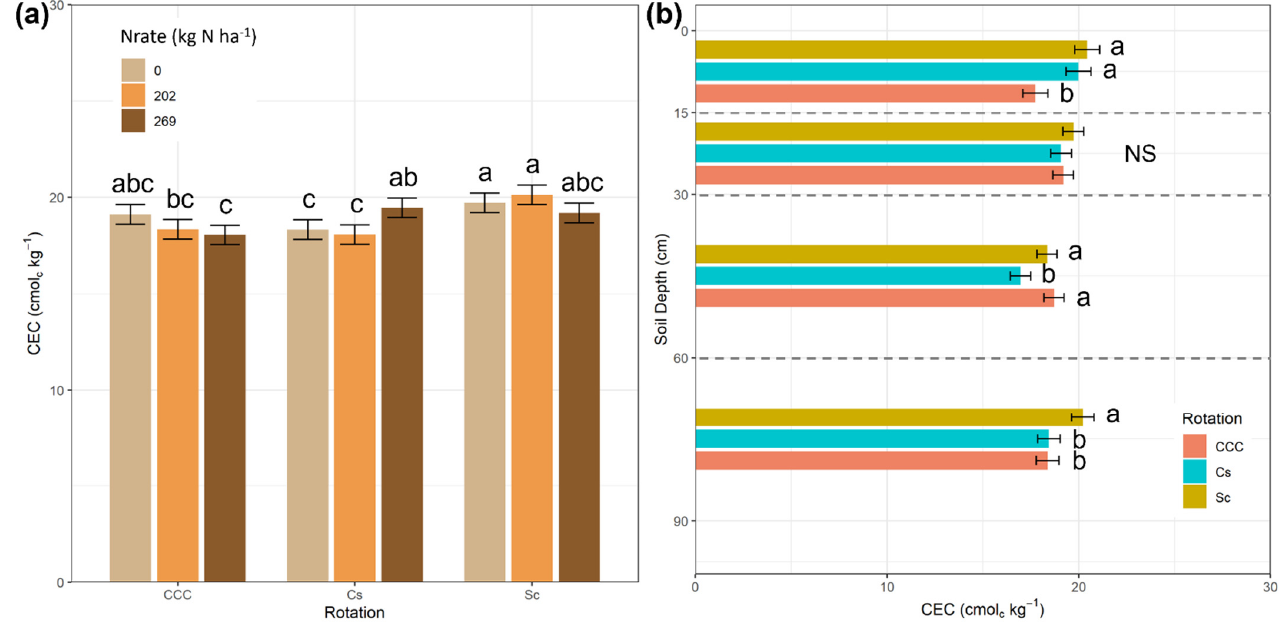
Figure 2. ( a ) Mean values of cation exchange capacity (CEC, cmol c kg − 1 ) by crop rotation and N fertilization rate, and ( b ) by crop rotation and depth. In all cases, bars show the mean values and error bars represent the standard error of the treatment means. The placement of bars within each depth range (0–15, 15–30, 30–60, and 60–90; cm) does not signify differences in sampling depth. Crop rotations are continuous corn (CCC), and the corn-soybean rotation (CS) as corn Cs and soybean (Sc) phase, respectively. The N fertilization rates were 0, 202, and 269 (kg N ha − 1 ). Within each panel and a given depth, means followed by the same lowercase letters are not statistically different ( α = 0.05). Lack of statistically significant differences among treatment means within a given depth is indicated by